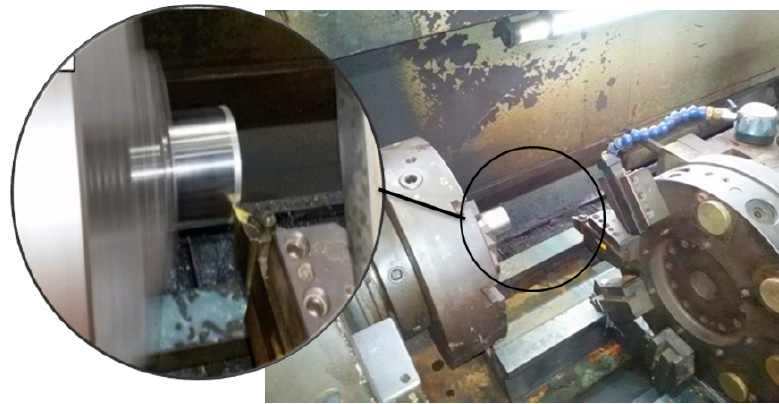
Figure 5. Machine setup.